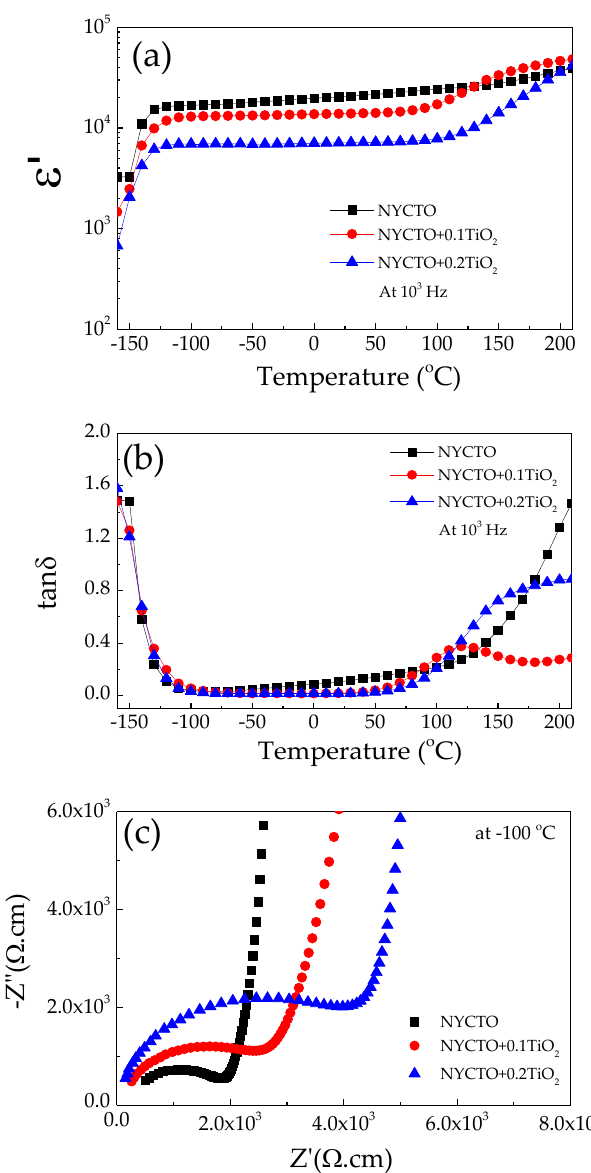
Figure 3. ( a , b ) Dielectric permittivity ( ε ′ ) and loss tangent (tan δ ) of NYCTO + xTiO 2 ceramics as a function of temperature ( − 150 – 200 °C). ( c ) Impedance complex plane plots (Z*) at − 100 °C, showing the electrical response on semiconducting grains.